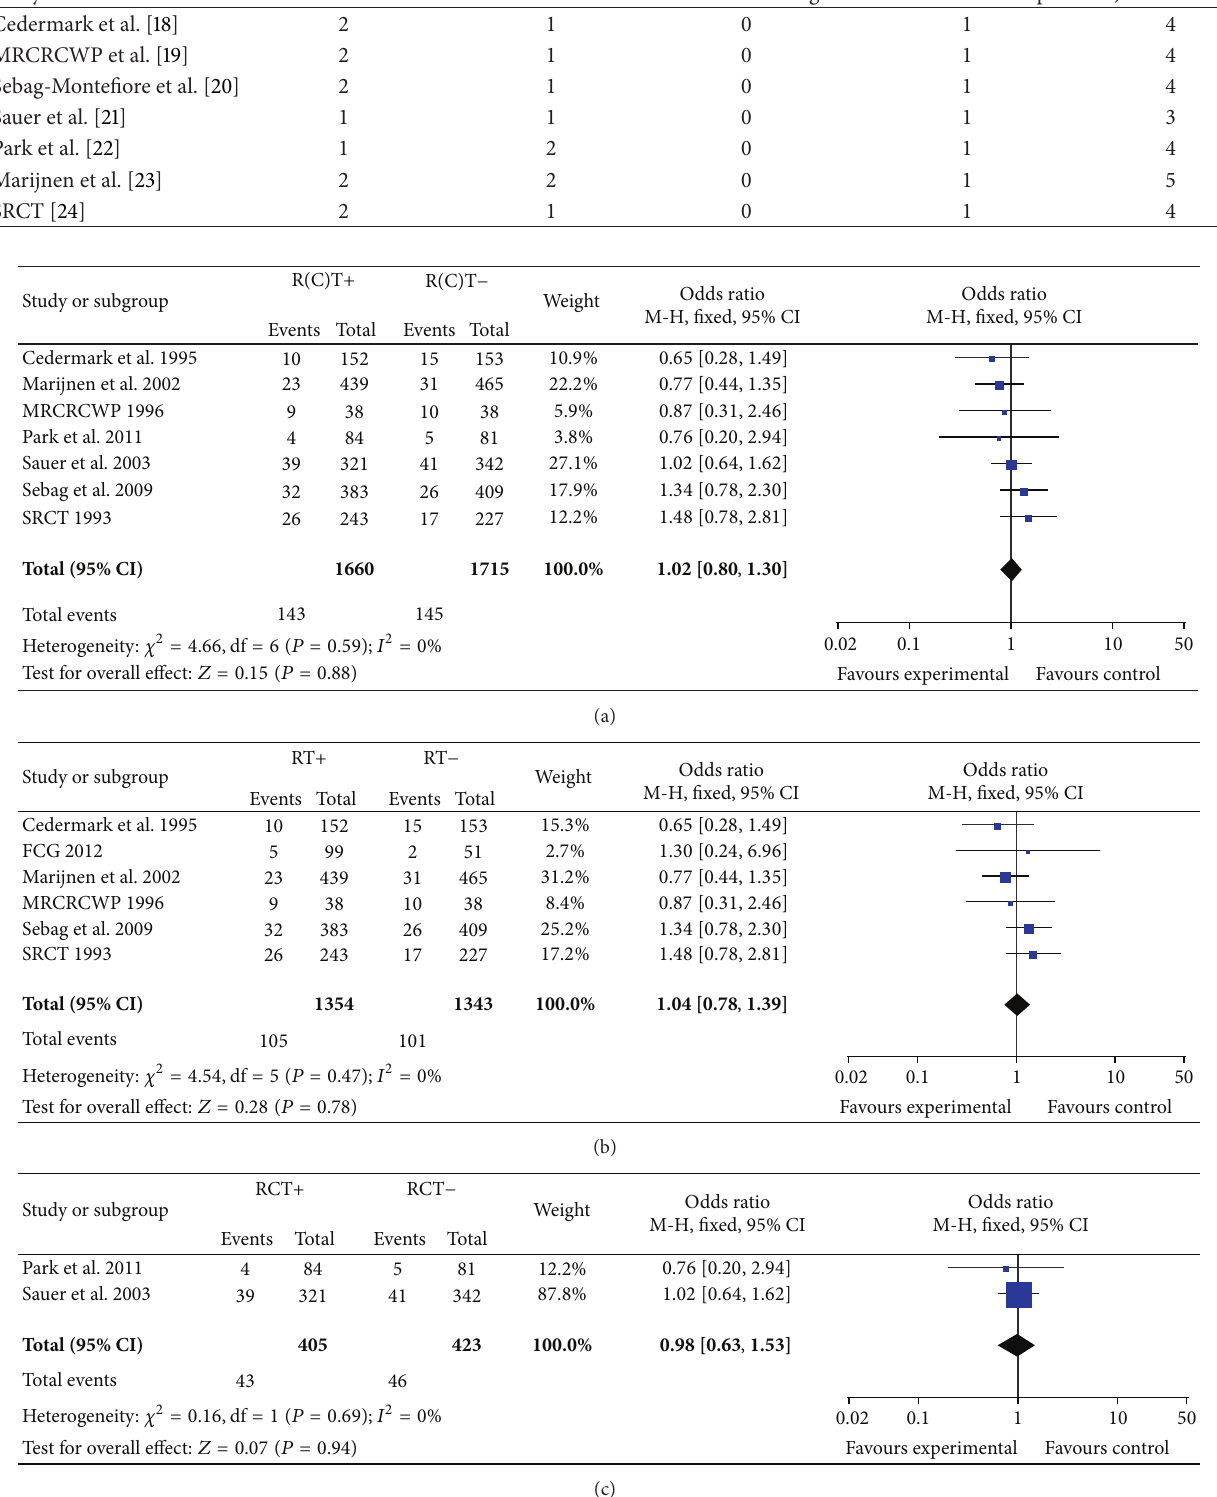
Heterogeneity: 𝜒 2 = 0.16, df = 1 (P = 0.69); I 2 = 0% Test for overall effect: Z = 0.07 (P = 0.94)